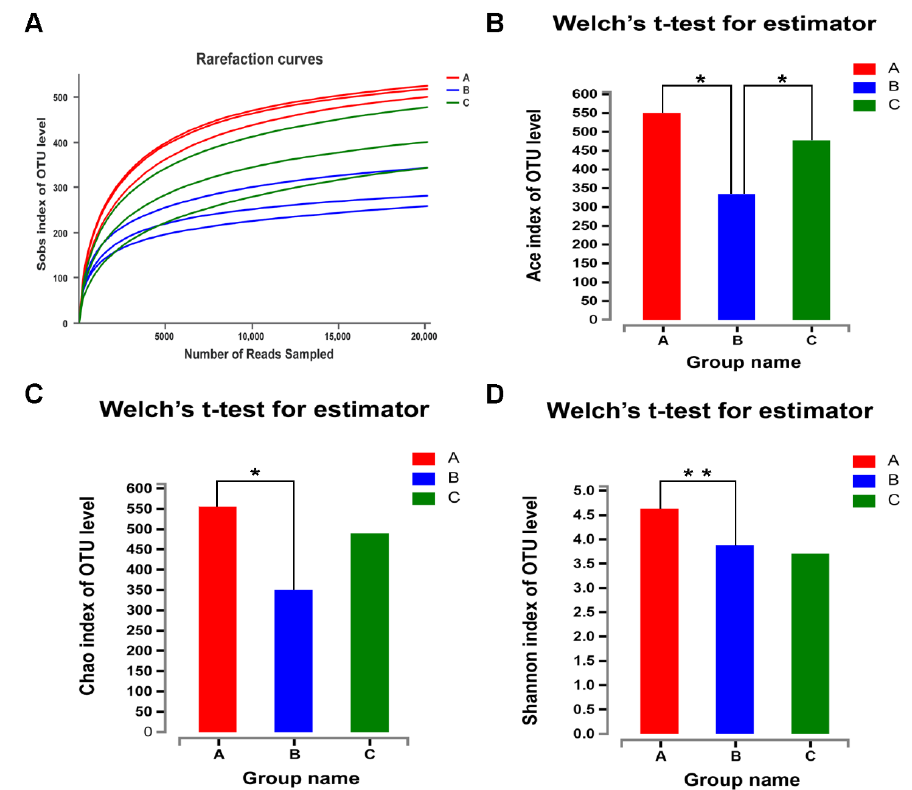
Figure 1. Rarefaction curves and di ff erent microbial diversity indices in groups A, B and C. ( A ) Rarefaction curves of the operational taxonomic units (OTUs) number at 97% similarity box plot for every sample. ( B – D ) Di ff erent microbial diversity indexes such as Ace, Chao and Shannon among groups A, B and C. The ACE, Chao1 and Shannon indexes are presented for a similarity of 97% between reads. * p ≤ 0.05, ** p ≤ 0.01. Group A: basal diet; group B: basal diet supplemented with antibiotics and zinc oxide; group C: basal diet supplemented with 0.06%